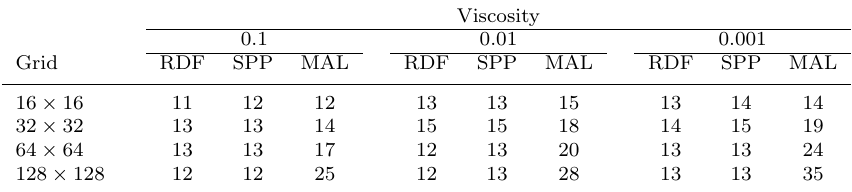
Table 7. Number of GMRES(20) iterations with the RDF, MAL and SPP preconditioners for unsteady Oseen problems (Q2-P1 FEM uniform grids). The parameters τ , α , γ are experimentally optimal.